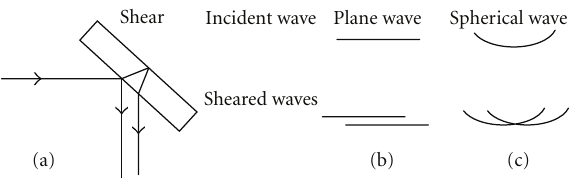
Figure 10: (a) Lateral shear interferometer in which the incident wave is split into two and sheared. (b) Schematic showing that the phase di ff erence between sheared plane waves is constant. (c) Schematic showing the phase di ff erence between sheared spherical waves is not constant and varies linearly in the direction of